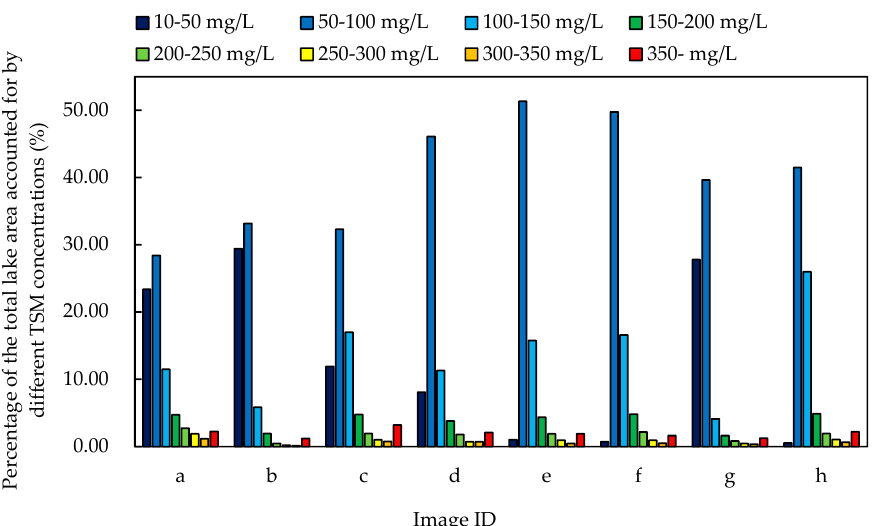
Figure 5. Percentage of total lake area accounted for by different TSM concentrations (percent) in Lake Taihu in early September 2011.